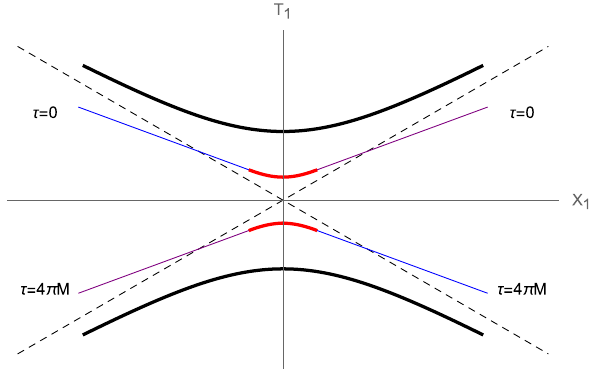
Fig. 11 Intersections of the complex-extended manifold with the real space. The blue lines represent the intersections of the δ − ρ surface with the real space. At the same time, the magenta lines represent the inter- sections of δ + ρ . For instance, starting from the blue line on the upper left at τ = 0, and evolving it in complex time up to τ = 4 π M, it reaches the blue line on the lower right. Similarly, for the red lines